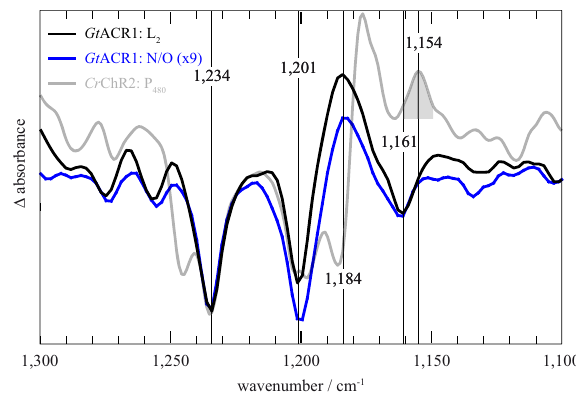
Fig. 3 Differences in the retinal absorption bands between Gt ACR1 and Cr ChR2. Gt ACR1 intermediate-minus-ground state difference spectra (L black, N/O in blue) compared to the P 480 difference spectrum of Cr ChR2 (gray) based on previously published data 15 . Gt ACR1 does not display a P 480 intermediate; thus, the Cr ChR2 P 480 spectrum is compared to the spectrum of a conducting state (L 2 ) and the late non-conducting N/O state. Spectra were scaled to the 1234 cm − 1 band. The N/O spectrum had to be ampli fi ed as indicated due to its low amplitude. The gray highlighted syn - band at 1154 cm − 1 of Cr ChR2 is not present in Gt ACR1, indicating that Gt ACR1 does not undergo a syn -cycle in contrast to Cr ChR2. The source data for this Fig. is given in Supplementary Data